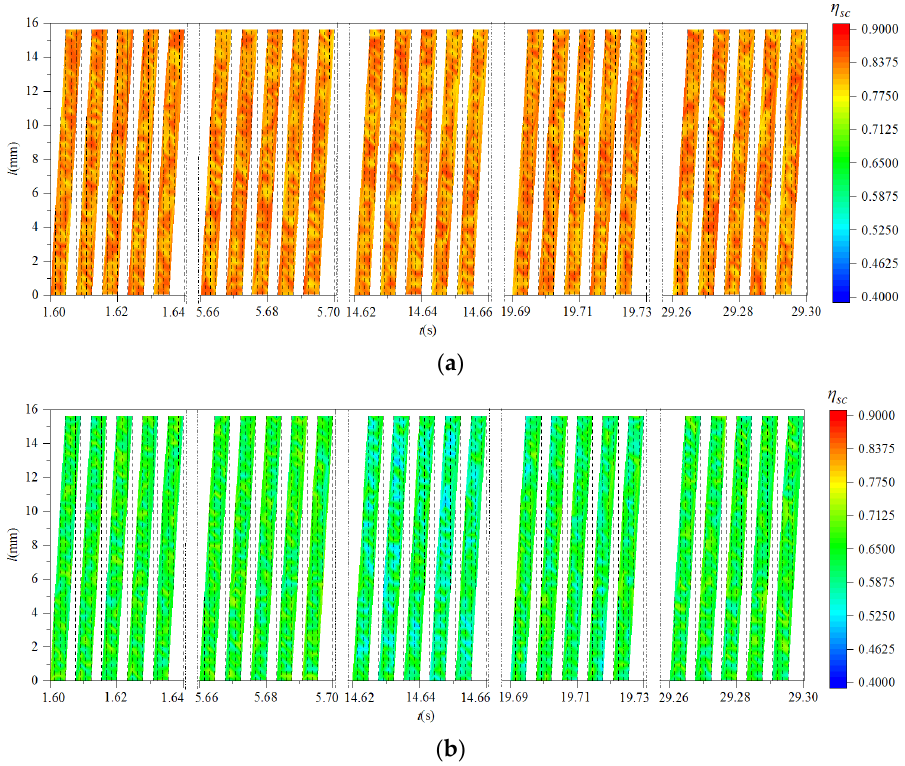
efficiency along the cutting edge was not consistent. Compared with different times, the shear energy-efficiency values of multiple cutter teeth were obviously different. At the